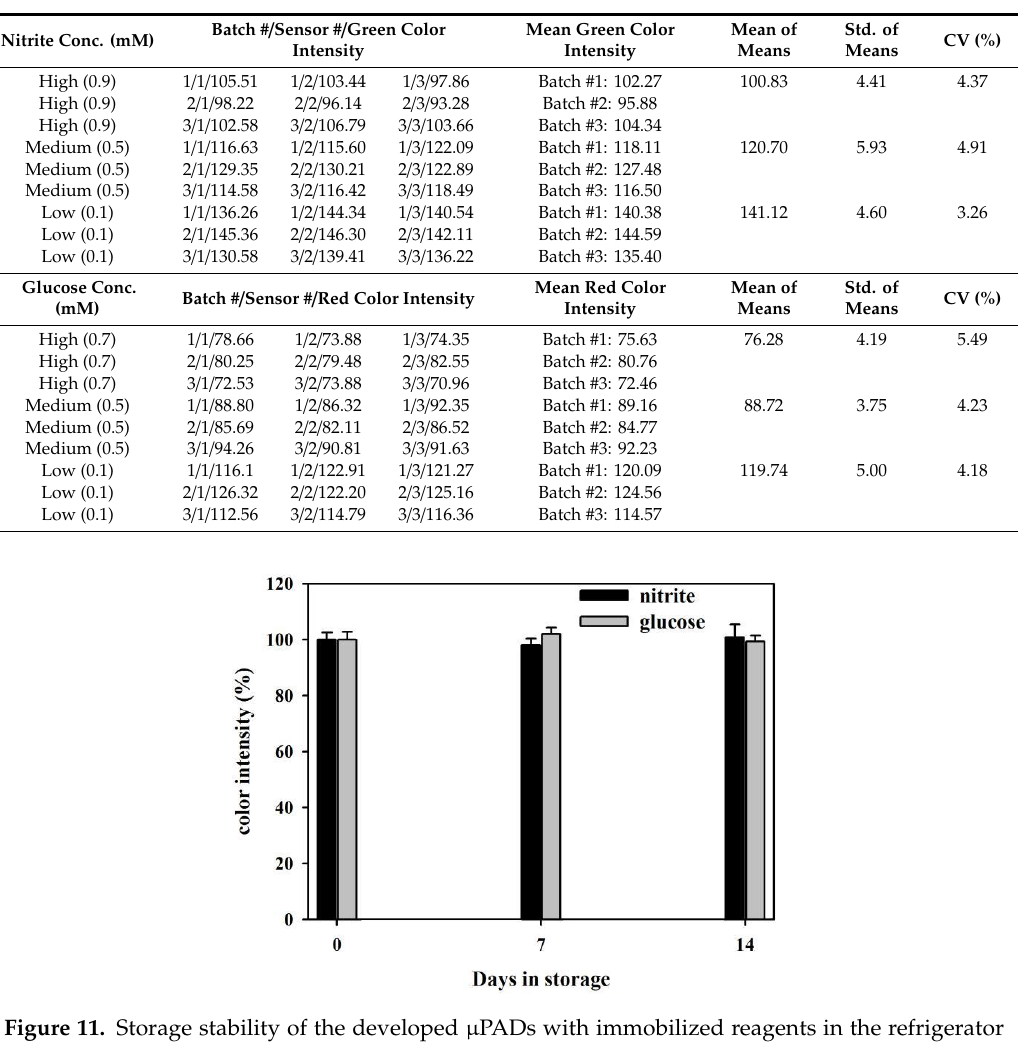
Table 4. Inter-assay coe ffi cients of variation (CV).